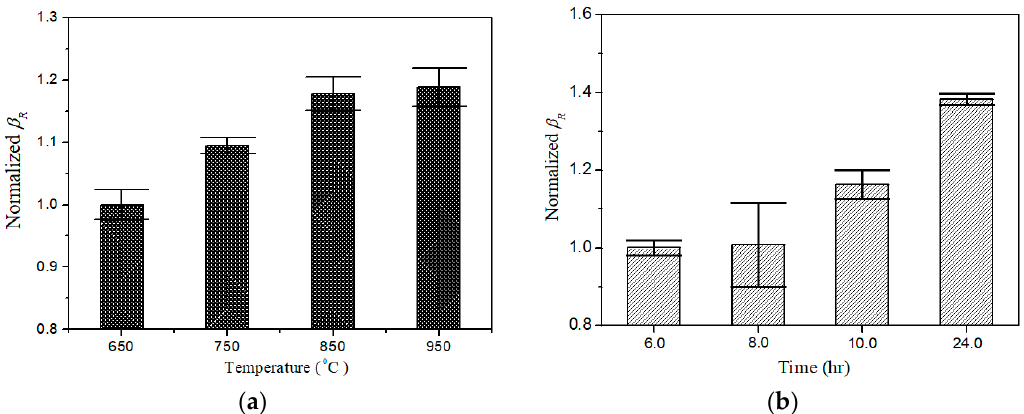
Figure 10. Variation of normalized for the specimens subjected to ( a ) thermal loading temperature with two hours’ holding time (by the reference of β R = 0.197, that of the specimen subjected 650 ◦ C thermal loading), and ( b ) different thermal loading time at the temperature of 750 ◦ C (by the reference of β R = 0.363, that of the specimen subjected 6 hours’ thermal loading).